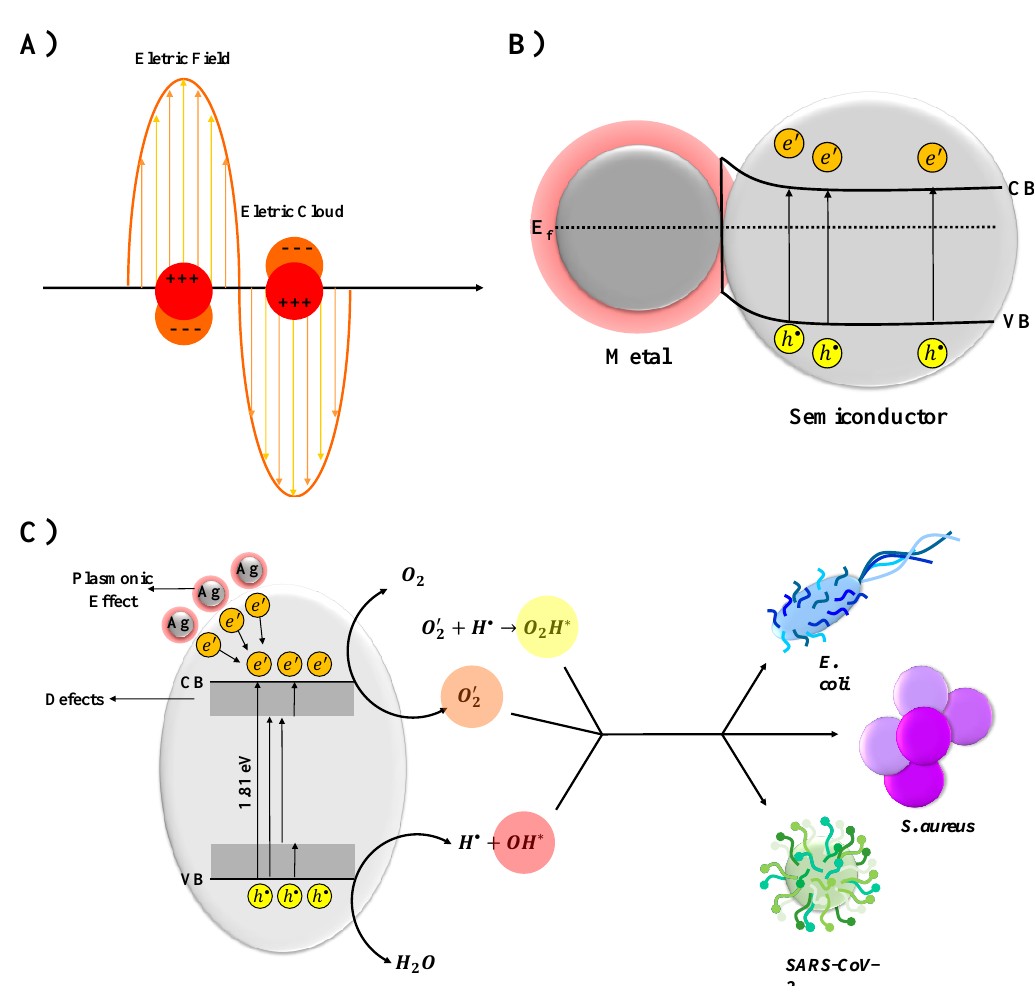
Figure 9. A schematic representation of plasmon-induced hot electrons over SiO2-Ag composite: ( A ) in Ag NP particles; ( B ) in metal semiconductor; and ( C ) proposed mechanism for biocidal activity. (CB and VB represent the conduction band and valence band, respectively.).